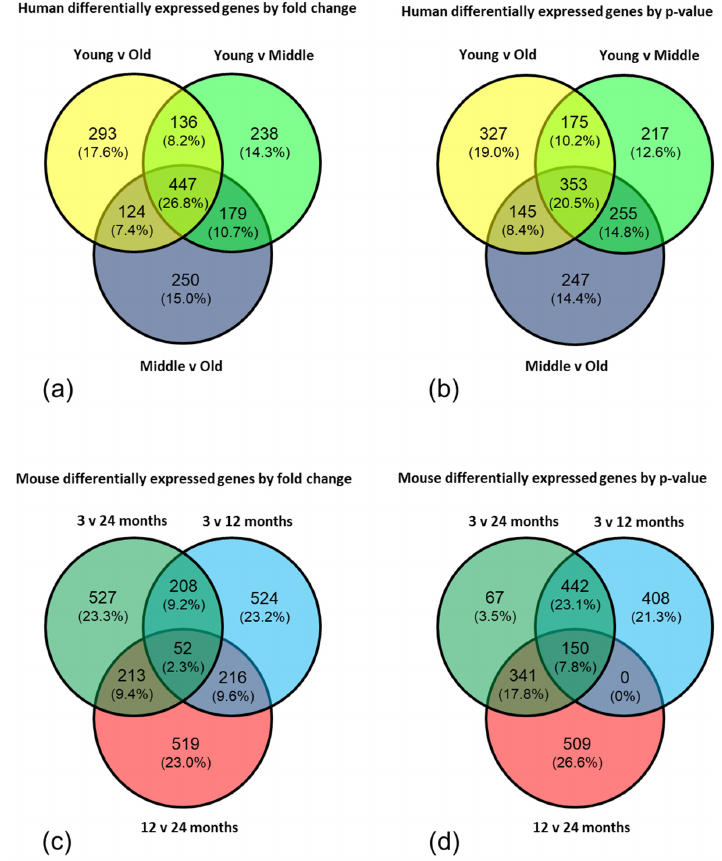
Figure 2. Analysis of top 1000 genes from each comparison in both the human and mouse datasets. In the human dataset, analysis of the genes sorted ( a ) by fold change identified 447 significantly, differentially expressed genes common to all three comparisons, and ( b ) by p -value identified 353 genes. In the mouse dataset, analysis of the genes sorted ( c ) by fold change identified 52 significantly, differentially expressed genes common to all three comparisons, and ( d ) by p -value identified 150 genes. The overlapping gene lists from each analysis were inputted into DAVID, with the aim of identifying gene networks and clusters of functionally similar genes. In the human dataset, analysis of the overlapping genes common to all three comparisons in the genes sorted by fold change identified three clusters with an enrichment score greater than 1.3 (DNA binding, kelch-like, tRNA modification), and in the genes sorted by p -value identified two clusters (DNA binding, apoptosis)(Table 1). In the mouse dataset, analysis of the overlapping genes common to all three comparisons in the genes sorted by p -value identified three clusters with an enrichment score greater than 1.3 (GTP binding, Armadillo-like, ion channel binding)(Table 1), but did not identify any clusters in the genes sorted by fold change using a high stringency filter.